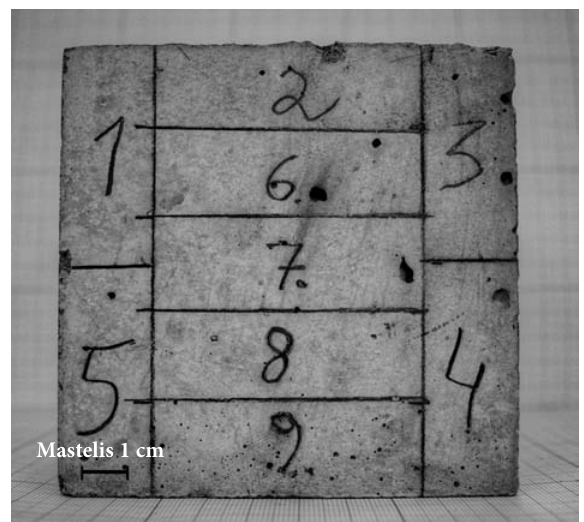
Fig. 1. Moisture measurement zones on the concrete cube